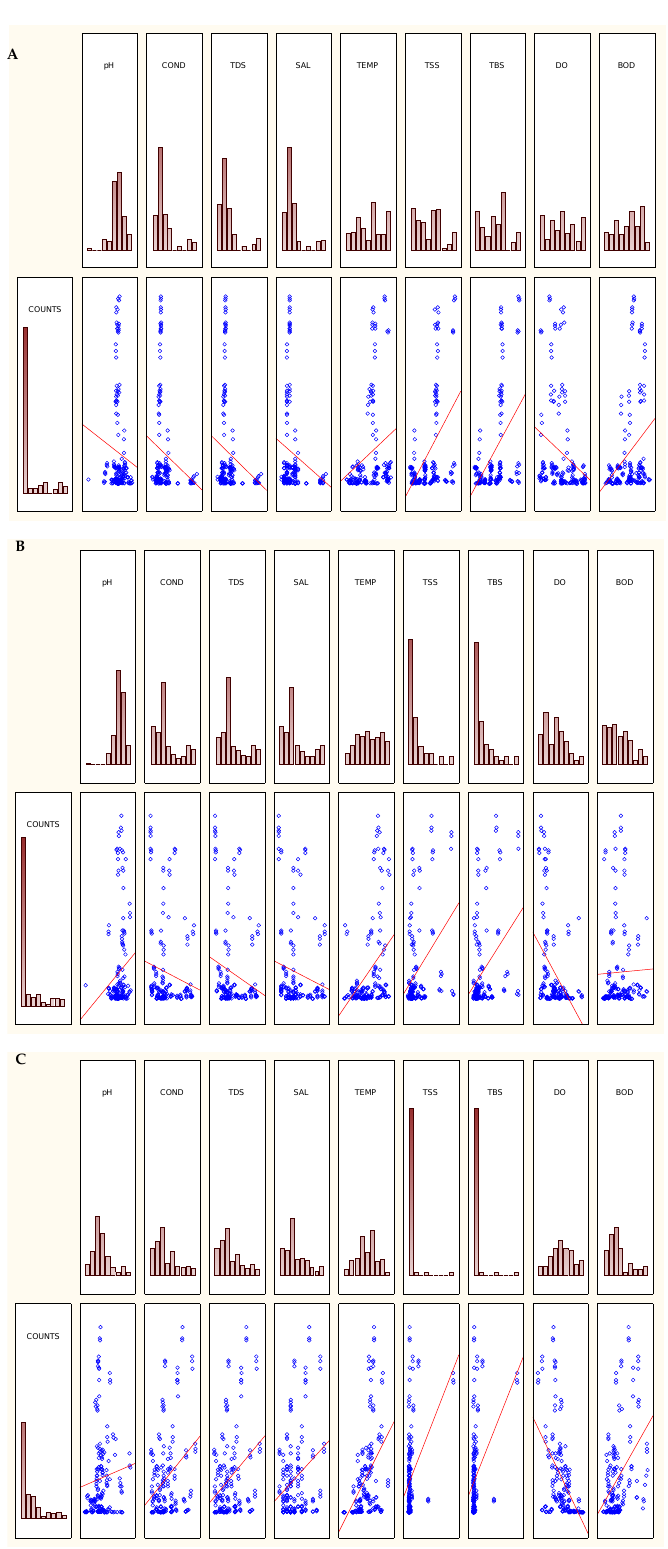
Figure 3. Correlation test for the relationship between the counts of presumptive Acinetobacter species and physicochemical variables. Counts histogram ( A – C ) correspond to Great fish, Keiskamma and Tyhume rivers, respectively. The trend line in the correlation charts indicates the nature of the correlation—positive or